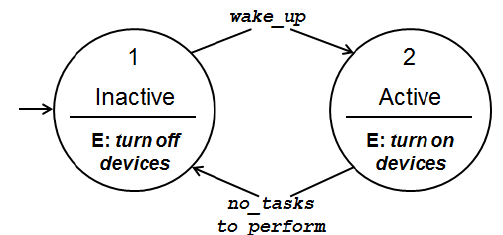
Figure 2. Finite state machine for ground sensor